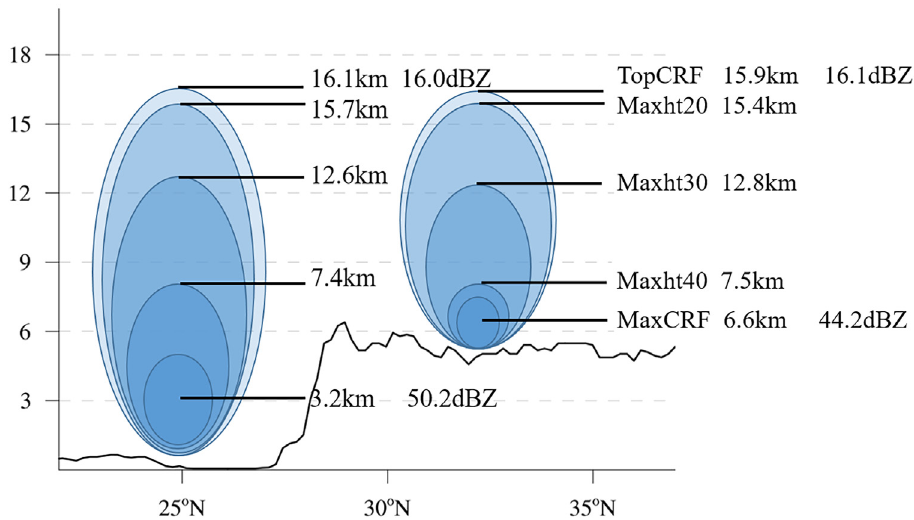
Figure 11. Conceptual model of the convective structure of the deep convective core in two different sub-regions. The curved black line shows the profile of the terrain height along the line 85° E from south to north.